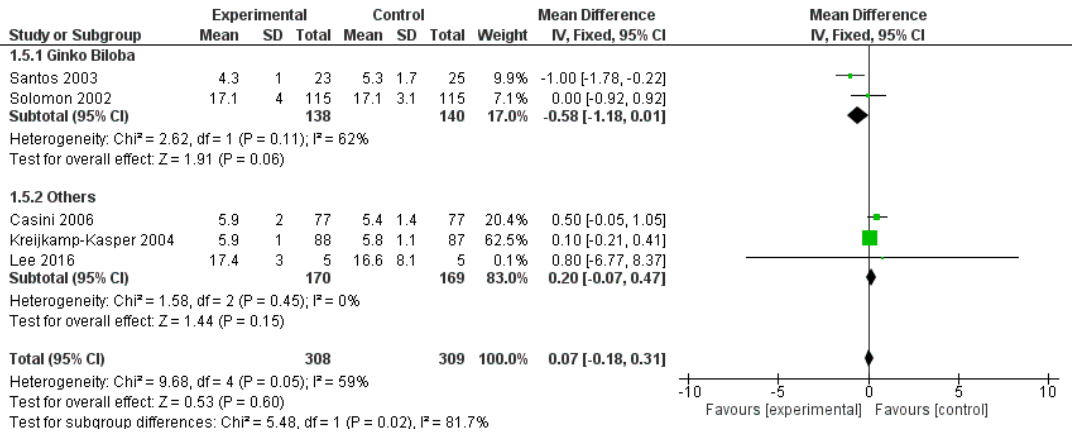
Figure 11. Pooled analysis of the impact of polyphenols on Wechsler Adult Intelligence Scale (WAIS) Digit Span field.